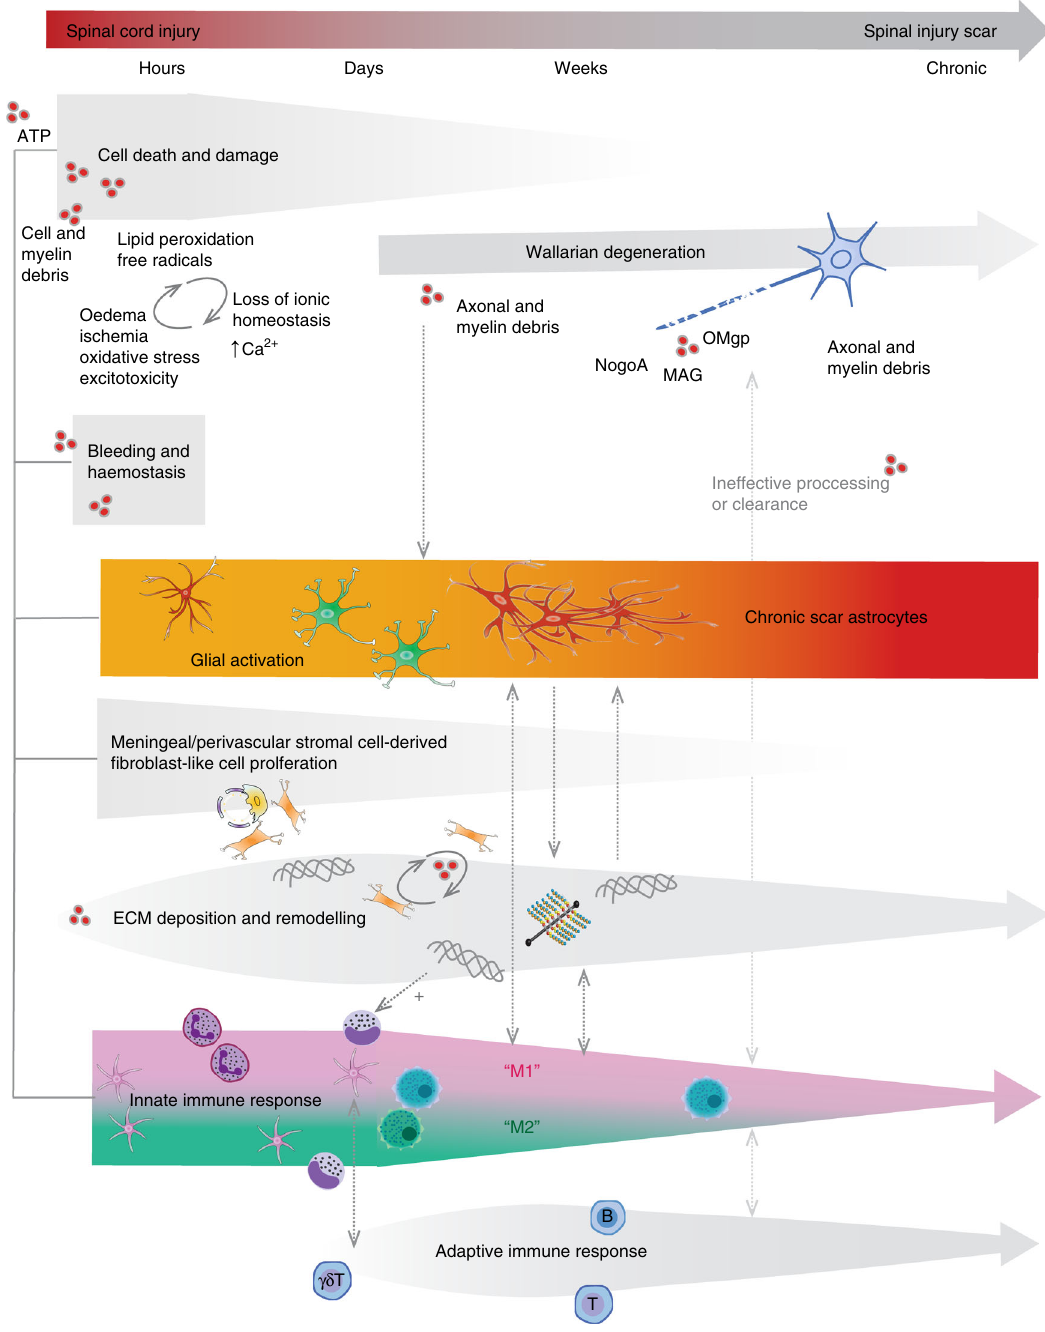
spinal injury scar in the acute and chronic phases of spinal cord injury are depicted in Fig.